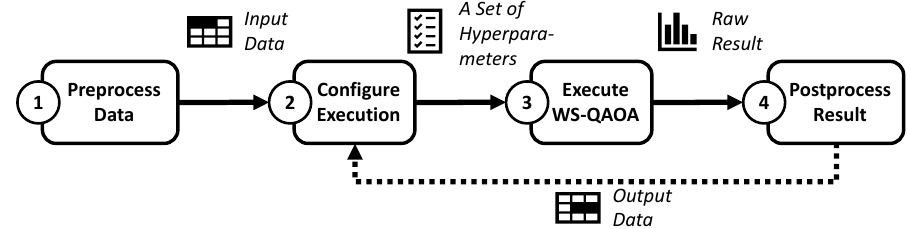
Figure 1. Selection of hyperparameters for WS-QAOA from a developer’s